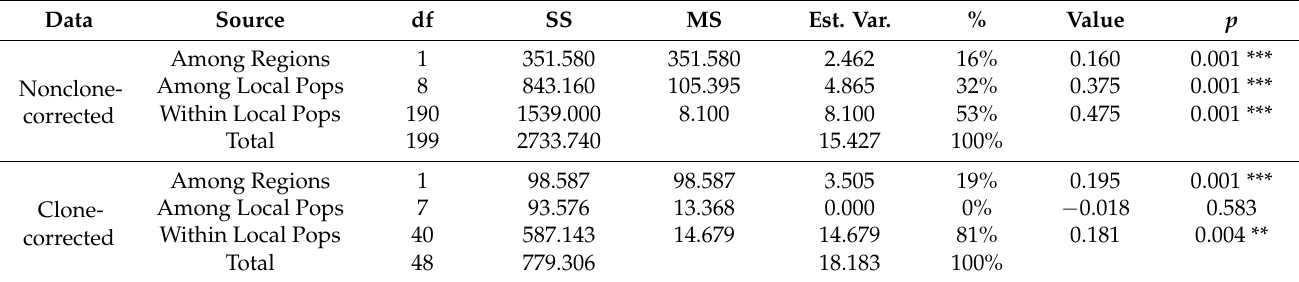
Table 3. Two-level hierarchical AMOVA of C. enelensis in